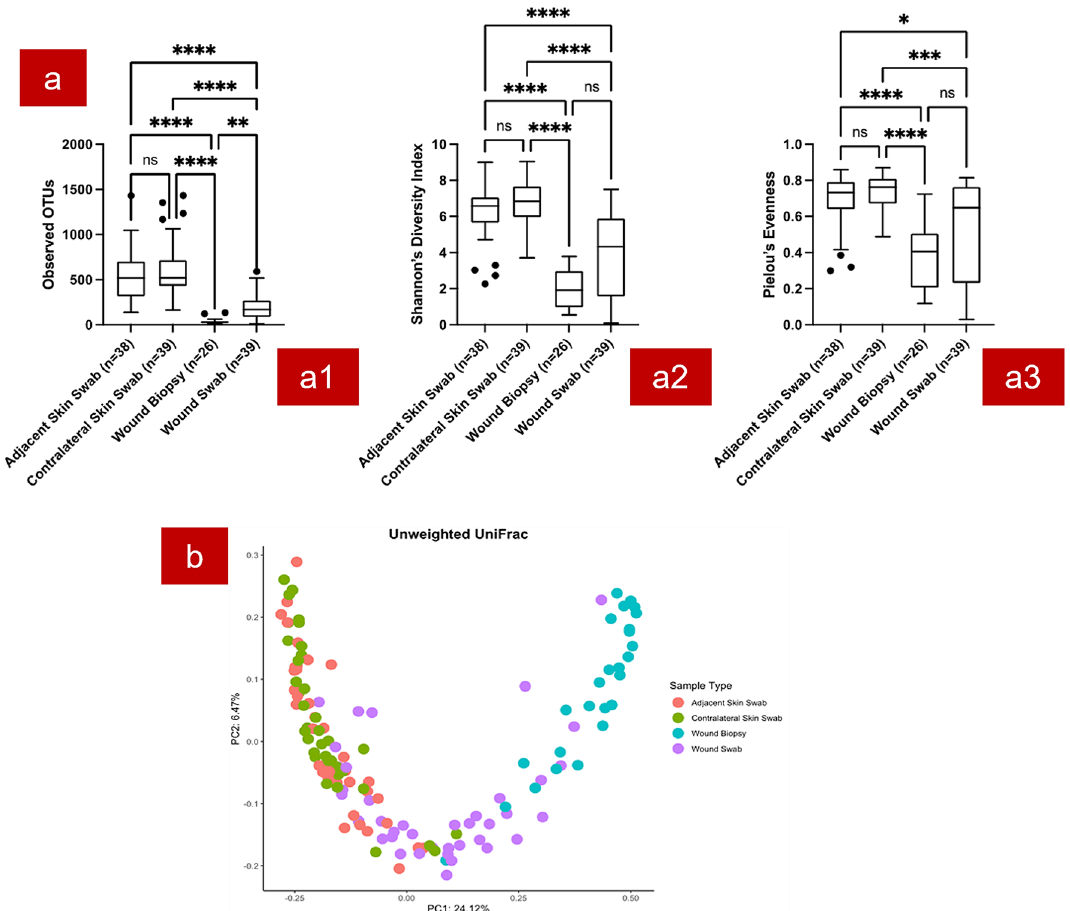
Figure 1. Diversity analysis results of different sample types. ( a ) Bacterial diversity based on sample location. Observed OTUs (a1); Shannon–Wiener diversity index (a2); Pielou’s index (a3); ( b ) Unweighted Unifraction distance matrix-based ordination (β diversity). Statistical significance of the difference between each sample type is denoted with asterisks. * p ≤ 0.05; ** p ≤ 0.01; *** p ≤ 0.001; **** p ≤ 0.0001; ns: p >